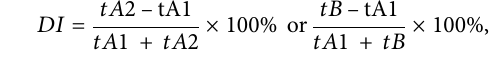
Frontiers in Pharmacology |